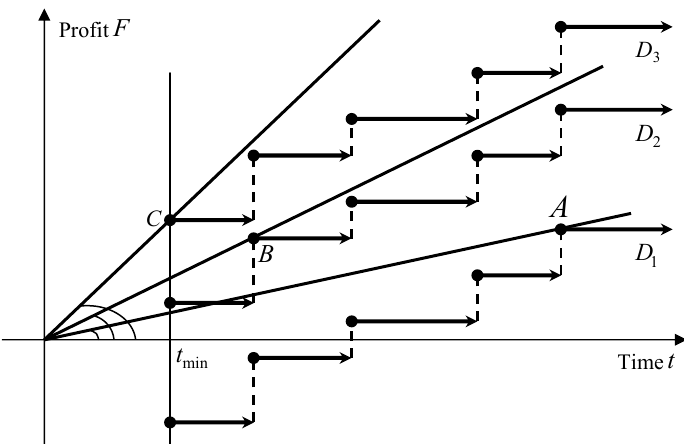
Fig. 2: Optimum solutions (A, B, C) of the transportation problem by the criterion of profit intensity, D